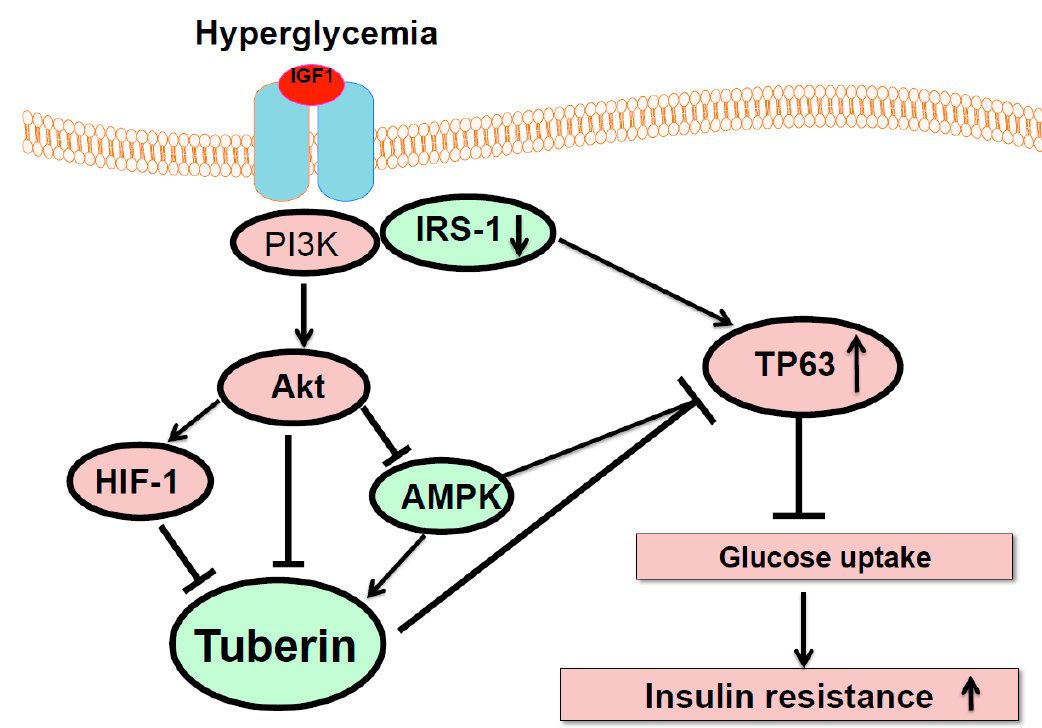
Figure 6. The proposed model of TP63’s role in insulin resistance. Hyperglycemia decreases IRS-1 to activate Akt/HIF-1 and downregulate tuberin/AMPK. The downregulation of IRS-1 increases TP63 under high glucose to decrease glucose uptake, suggesting that TP63 may be involved in insulin resistance in diabetes.